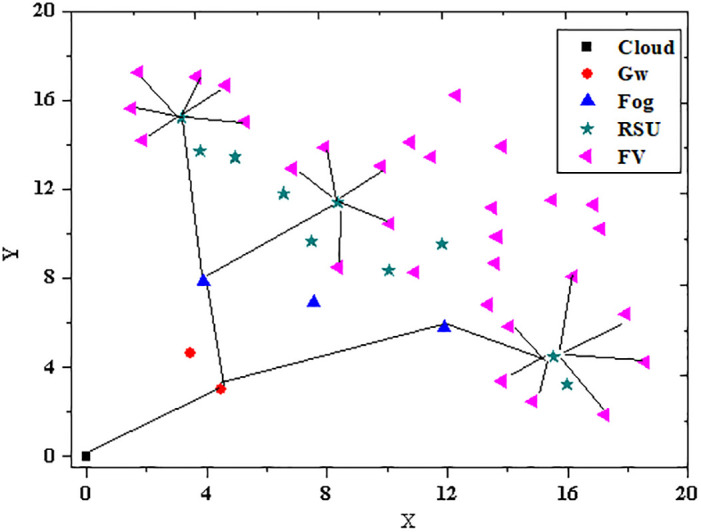
ND analysis of Scenario A.